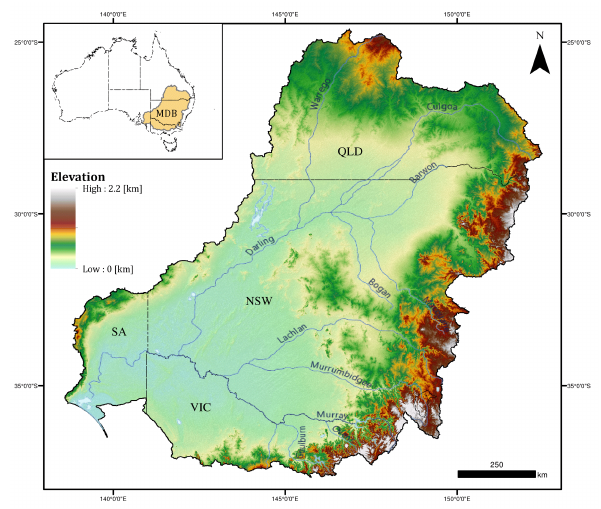
Figure 1. Major rivers and topography of the Murray–Darling Basin. Source: DEM (Geoscience Australia and CSIRO,